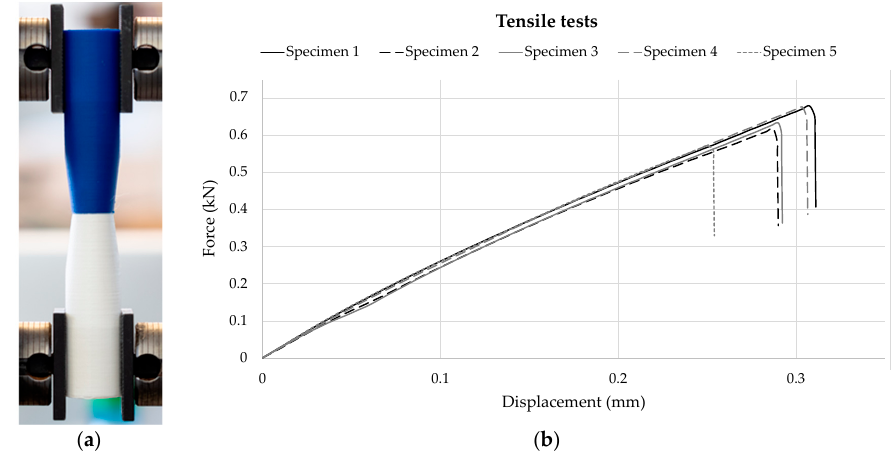
Figure 6. ( a ) Testing set-up of the tensile tests with the clamped multi-material test specimen made of PLA (white) and ABS (blue) and ( b ) corresponding force-displacement curve recorded by